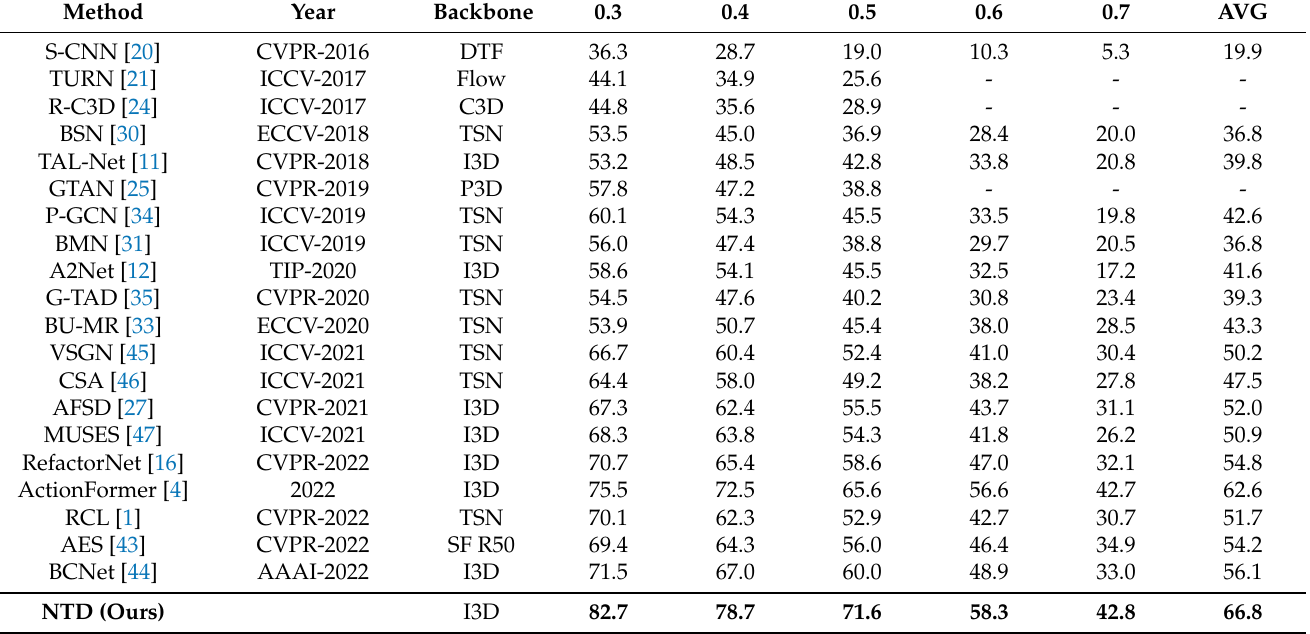
Table 1. Comparison with state of the art (THUMOS-14). We report the precision at different tIoU thresholds (mAP@tIoU) as well as average mAP in [0.3:0.1:0.7] (mAP@avg). The best results are in